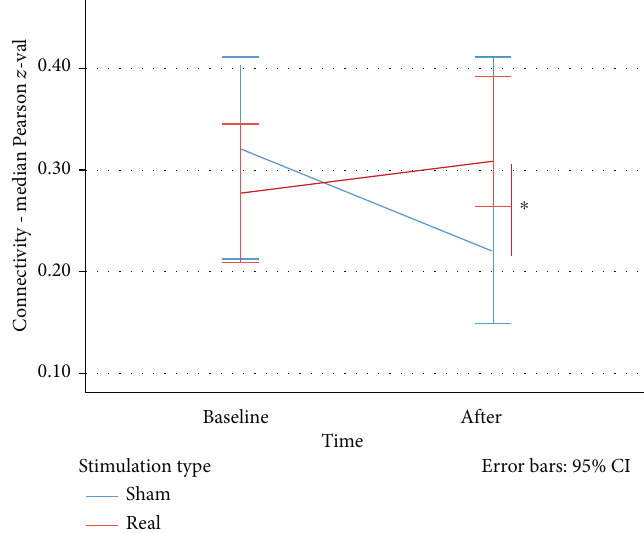
Figure 7: Changes in rs-fMRI connectivity (in percentage) between lDLPFC and IPL using the bifrontal tDCS